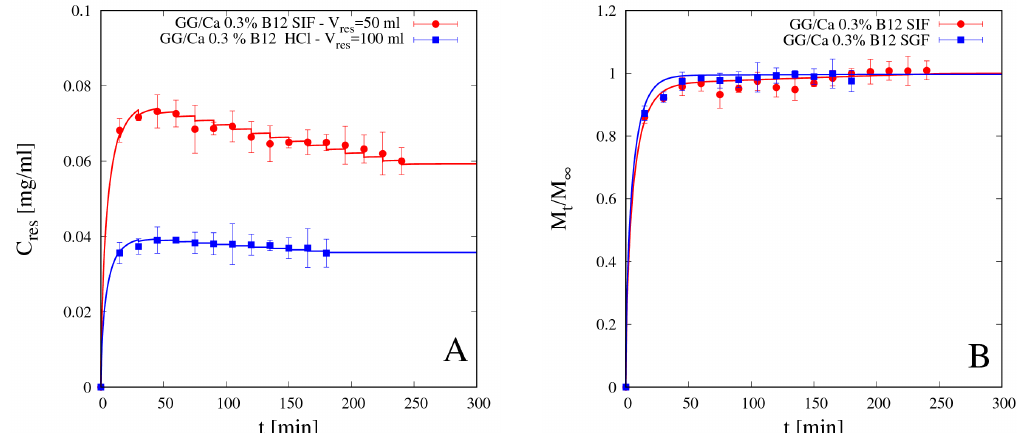
Figure 12. Differential ( A ) and integral release curves ( B ) for vitamin B12 from beads GG/Ca 0.3% without laponite in SGF and SIF. Continuous lines represent model predictions from Equations (11)–(13). Estimated values of the B12 diffusivity D dsg are reported in Table 5. Table 5. Vitamin B12 diffusivity in the swollen gel D dsg and transfer rate coefficient k bgsg for two different bead formulations (with and without laponite) and two different media SGF and SIF. Beads D dsg in SGF [m 2 / s]